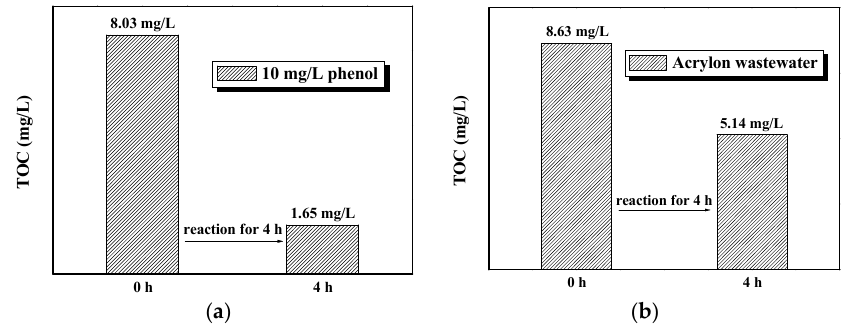
Figure 7. Photocatalytic activity test for ( a ) 10 mg/L phenol and ( b ) diluted acrylon wastewater. Reaction conditions are the same as those in Figure 6.